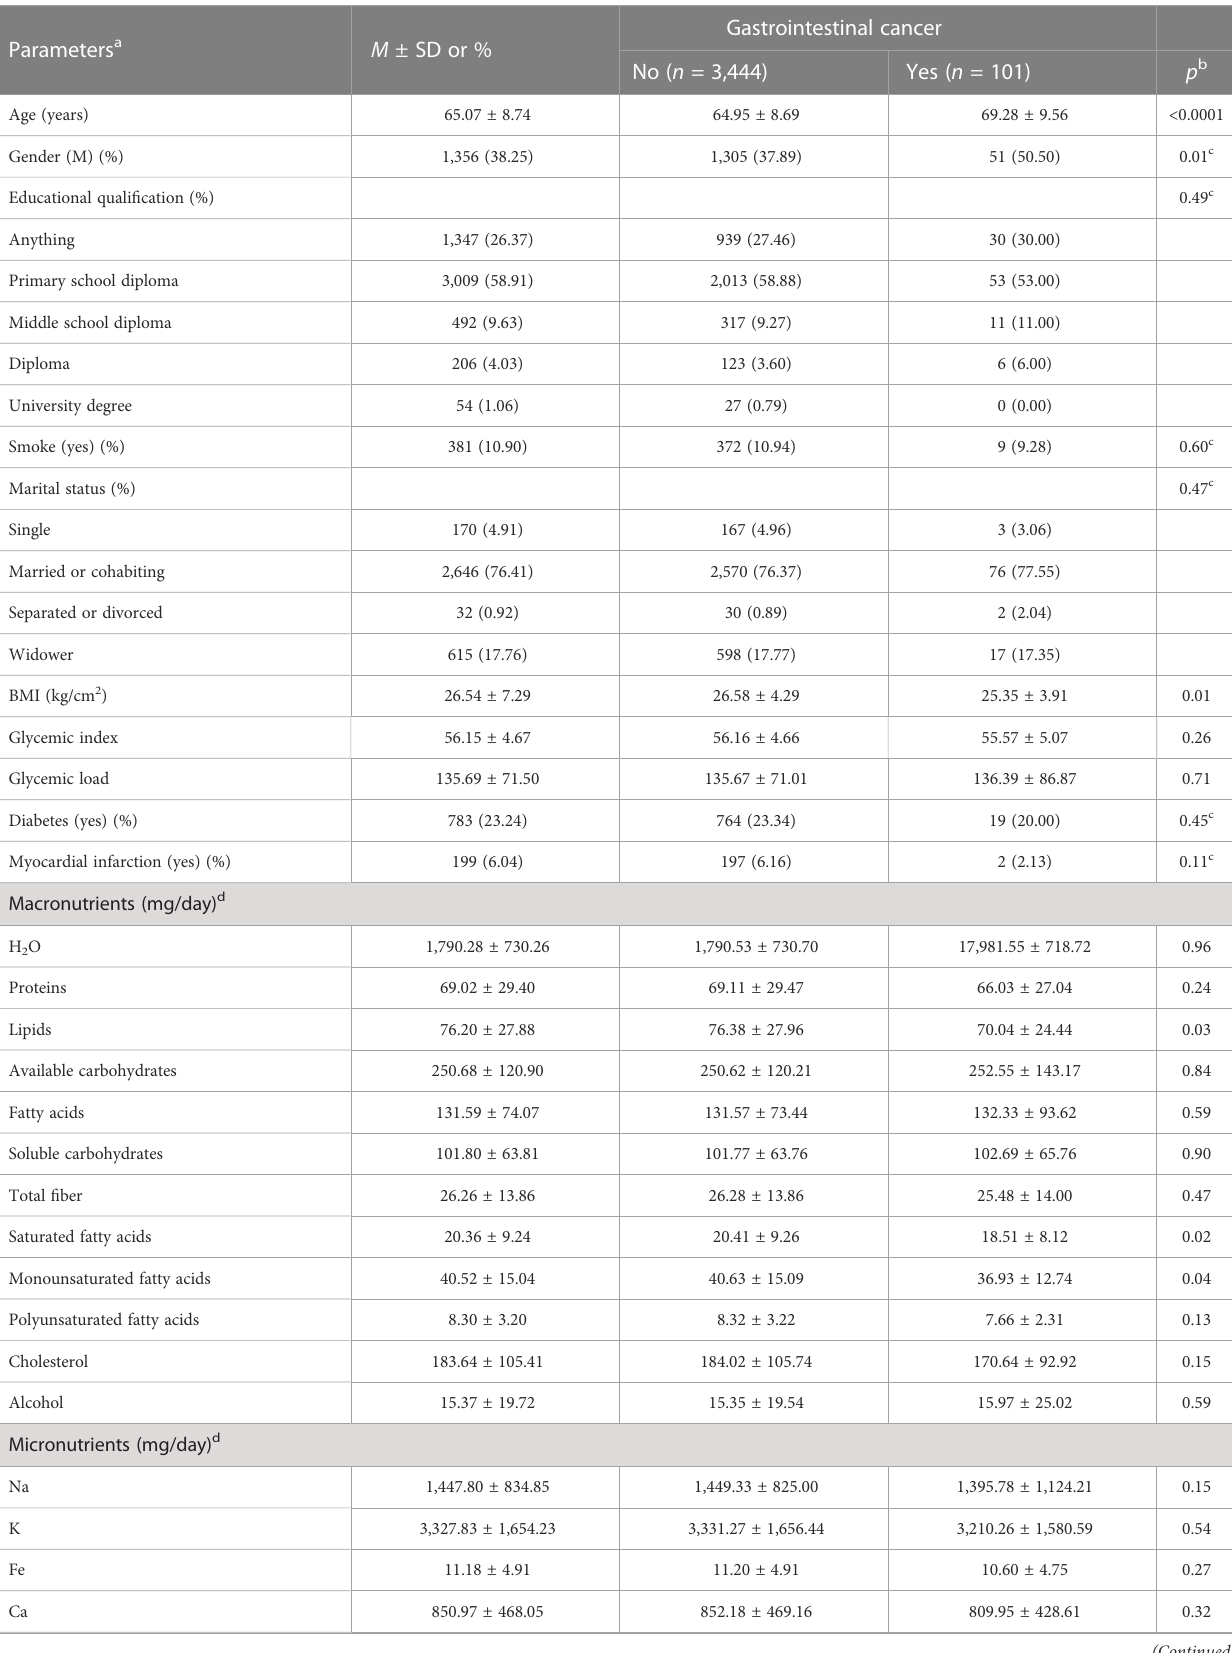
TABLE 1 Baseline and comparison characteristics of macro- and micronutrient intake in patients with and without gastrointestinal cancer in the ONCONUT study ( n =